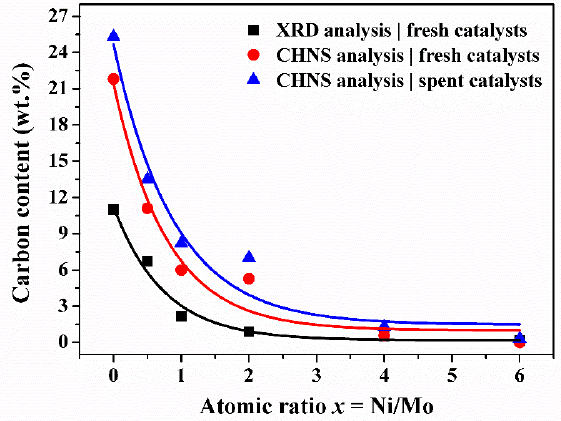
Figure 8. Relation of the total carbon content and carbon content determined from XRD data with atomic ratio x = Ni/Mo for the calcined and reduced Ni x MoC–SiO 2 (400/600) catalysts and calcined MoC–SiO 2 (700) catalyst.